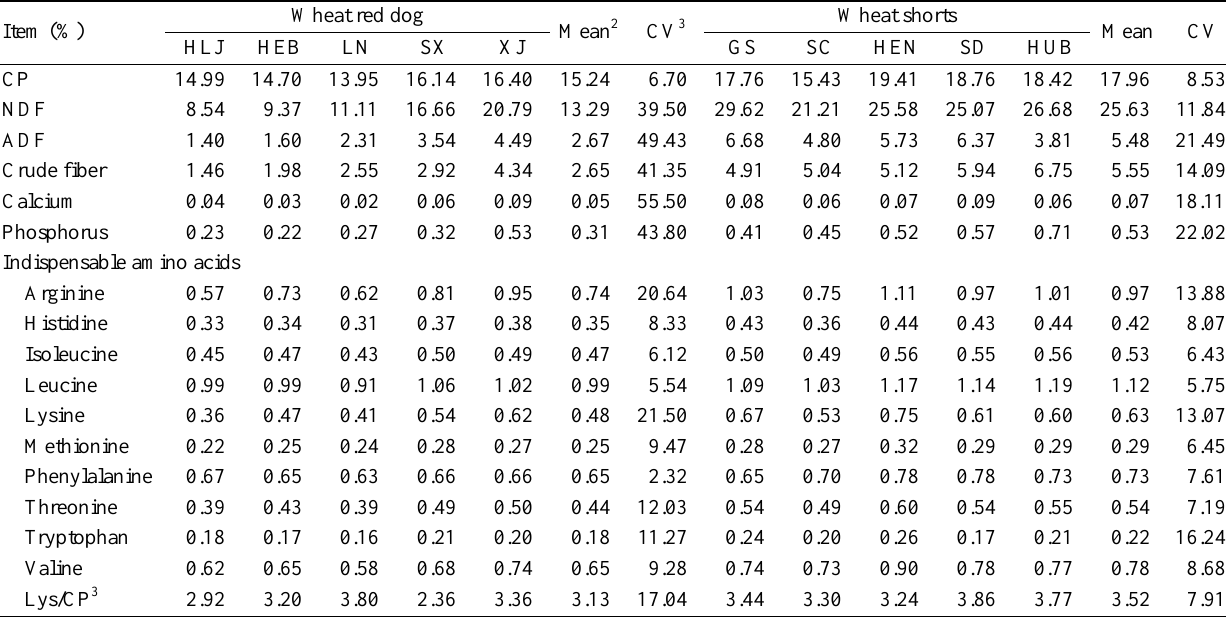
Table 6. Chemical analysis of ten samples of wheat shorts and red dog used in Exp. 2 (%, DM) 1 Item (%)